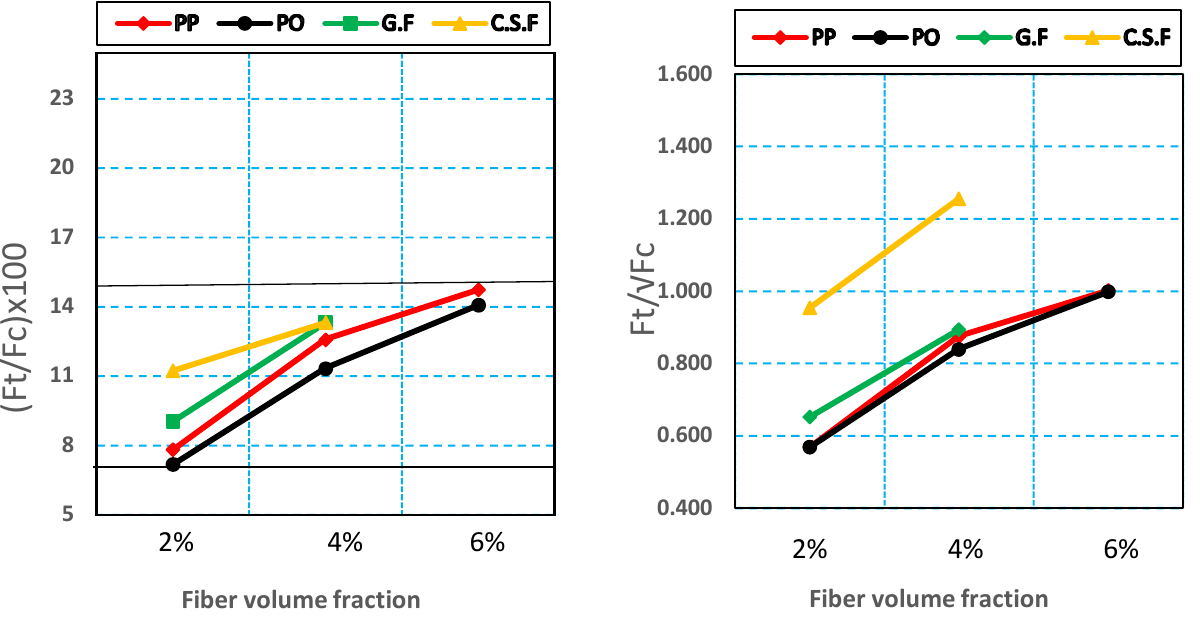
Figure 19. Relationship between tensile strength and compressive strength of FRC and ECC speci- men.